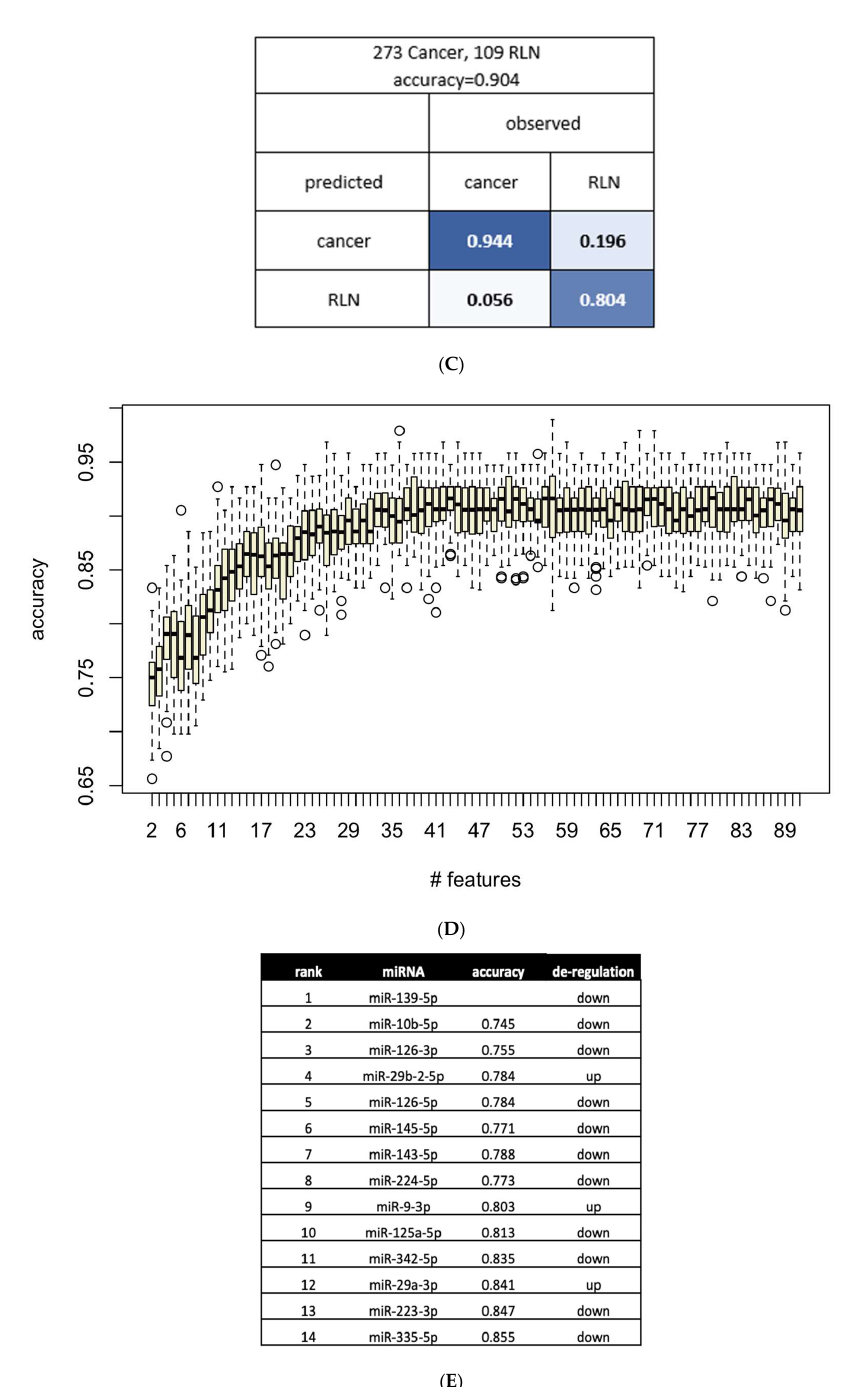
Figure 3. MiRNA expression as a classifier to distinguish lymphoma from reactive lymphoid proliferation (RL). ( A ) ROC curves from the test dataset of 100 times of four-fold cross-validation using the 90-miRNA classification model to differentiate lymphoma samples and RL. The black line indicates the average ROC curve. ( B ) Performance metrics of the classification model to distinguish lymphoma from RL. ( C ) Confusion matrix of the classification model from 100 times of four-fold cross-validation. ( D ) Classification accuracy for distinguishing lymphoma and RL with respect to the increasing number of miRNA features included in the classification model. ( E ) Top 14 miRNAs that achieve 85.5% classification accuracy in distinguishing between lymphoma and RL. Abbreviations: ROC, receiver operating characteristic; AUC, area under the